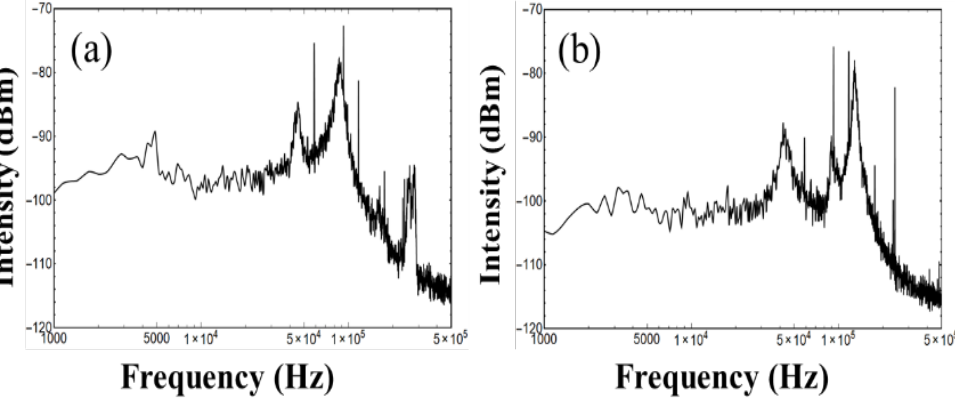
Figure 3. Measured intensity fluctuations of ( a ) single-soliton state with output averaged power of 25 mW; ( b ) bound-soliton state with output averaged power of 55 mW. The span range is from 1 kHz to 500 kHz. For direct comparison, the measurement results for both states are performed with the same averaged optical power incident on the photo-detector through the use of an optical attenuator.